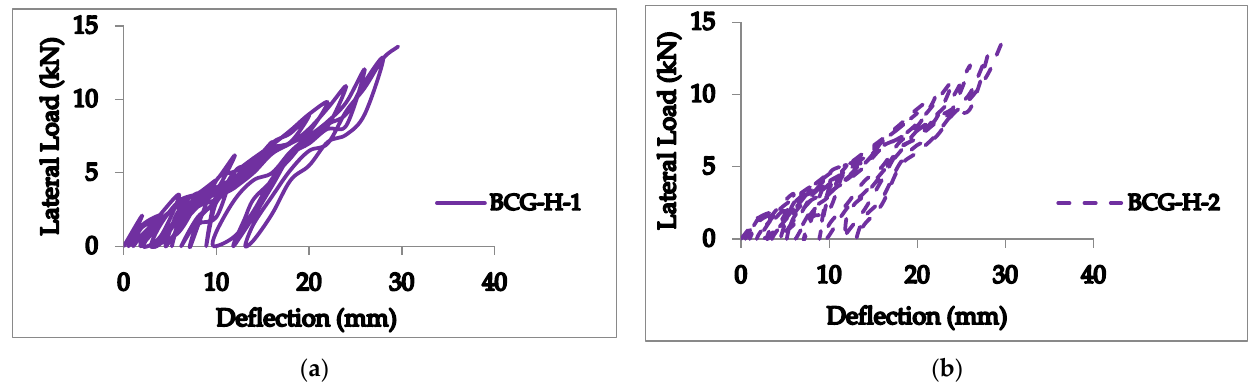
Figure 9. Hysteretic curves of hollow GFRP beam-columns. ( a ) Specimen 1; ( b ) specimen 2.